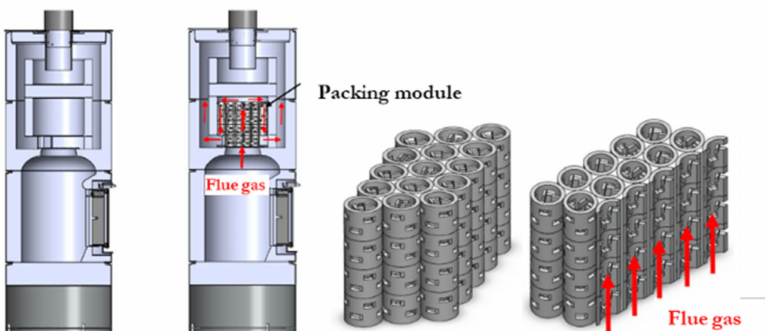
Figure 11. Packing module integrated in a slow-heat-release appliance between the main and post- combustion chamber [60] (translated into English). Reprint with permission from M. Aleysa, P. Leistner, Verbesserung des Verbrennungs- und Emissionsverhaltens in biomassebetriebenen Einzel- raumfeuerungsanlagen durch den Einsatz spezieller Einbauten; Copyright 2016, Fraunhofer Institute for Building Physics